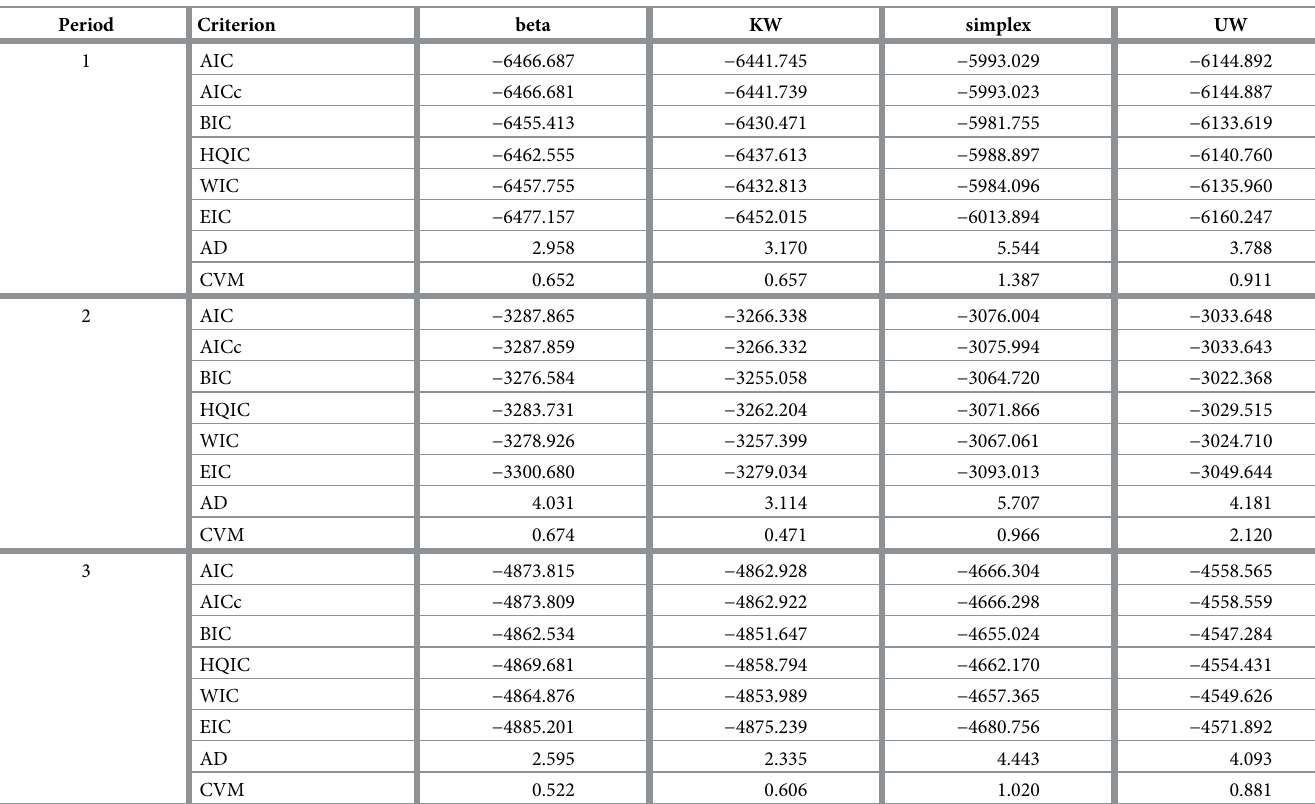
Table 8. Goodness-of-fit measures.